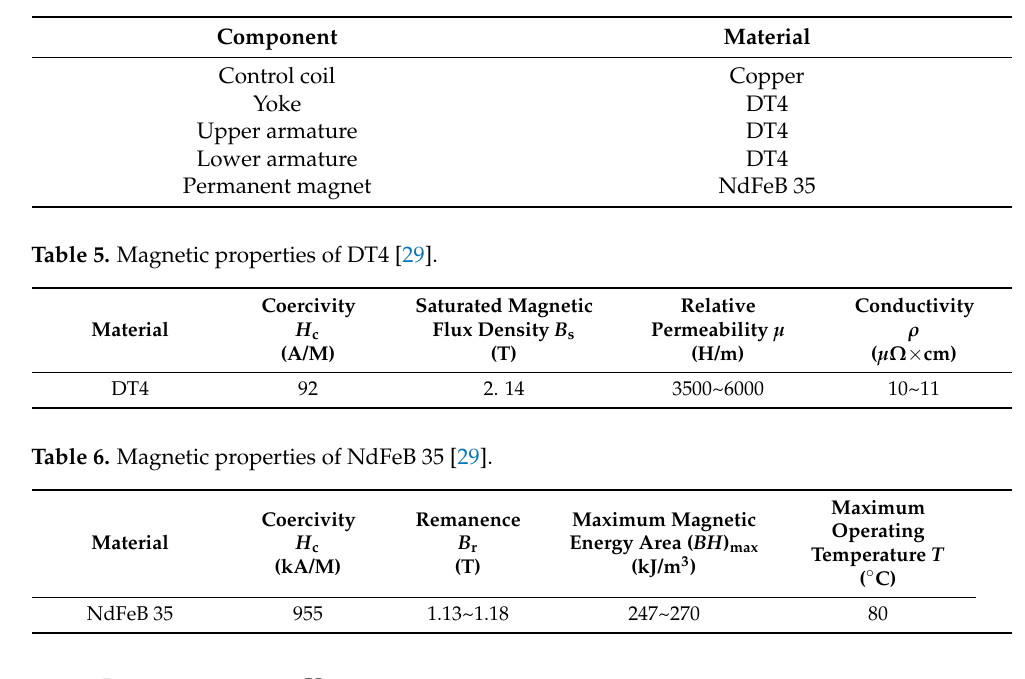
Table 4. The materials used for the key structure.